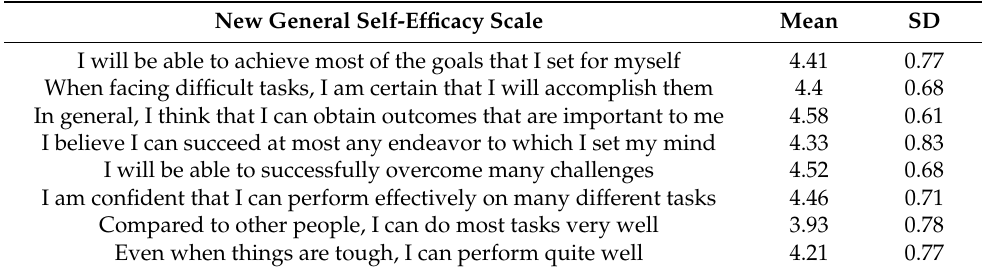
Table 3. Items of the New General Self-Efficacy